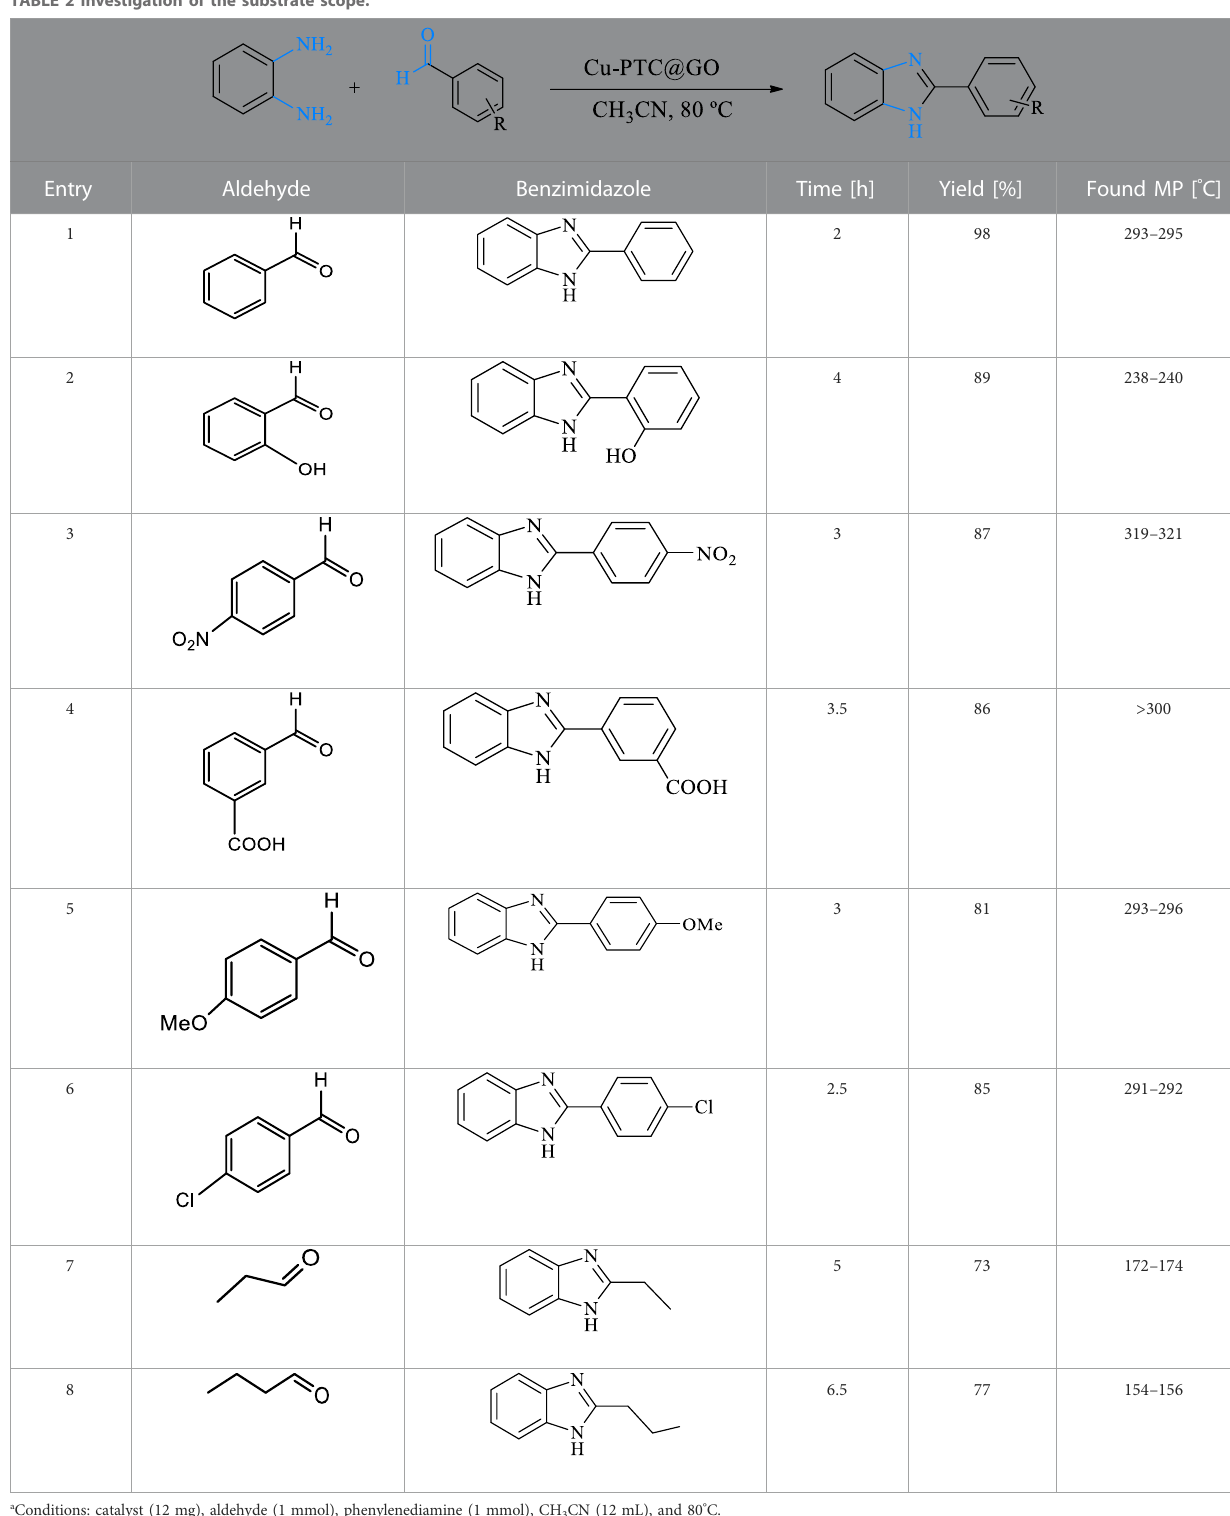
TABLE 2 Investigation of the substrate scope.